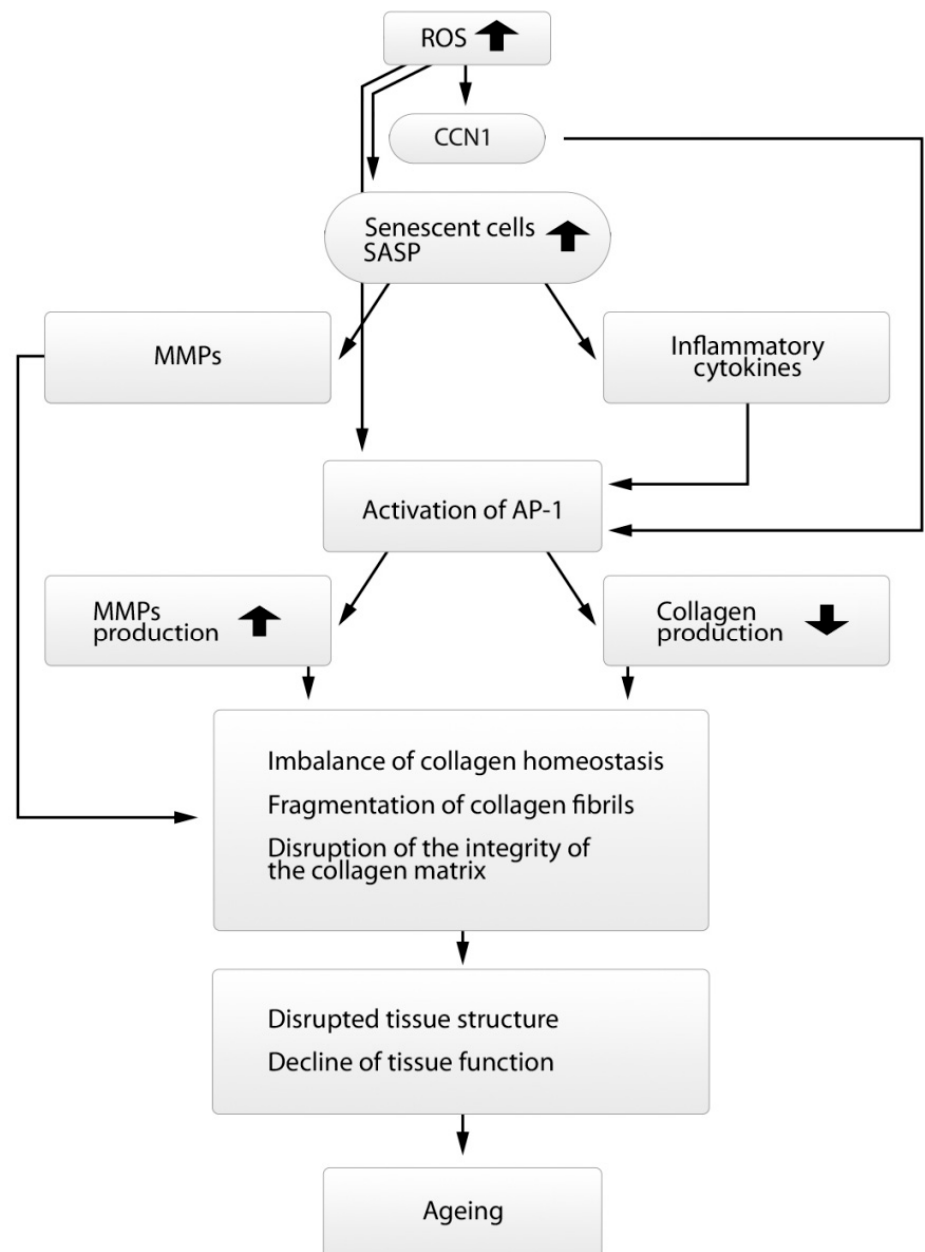
Figure 4. Scheme of the main signaling pathways involved in the process of collagen homeostasis disruption.